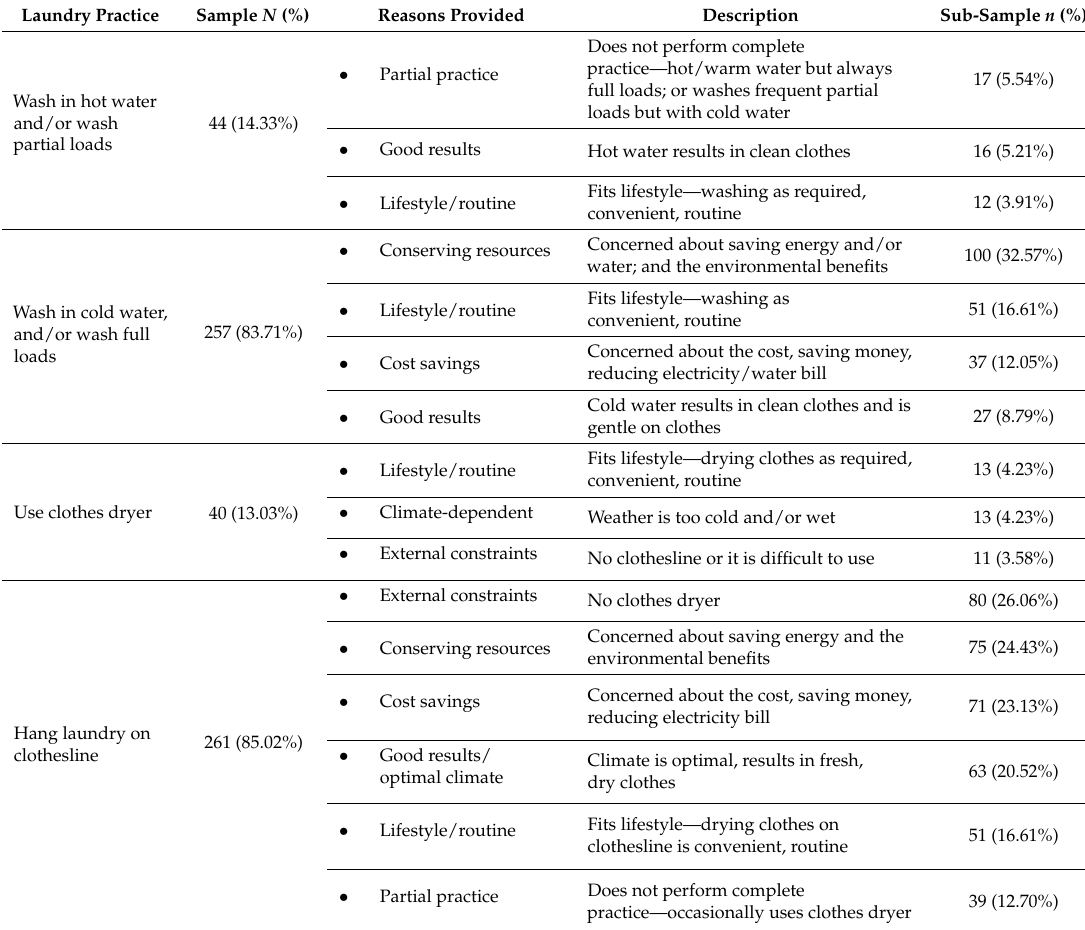
Table 1. Reasons given for engaging in energy-efficient and energy-inefficient practices in the laundry domain ( N =